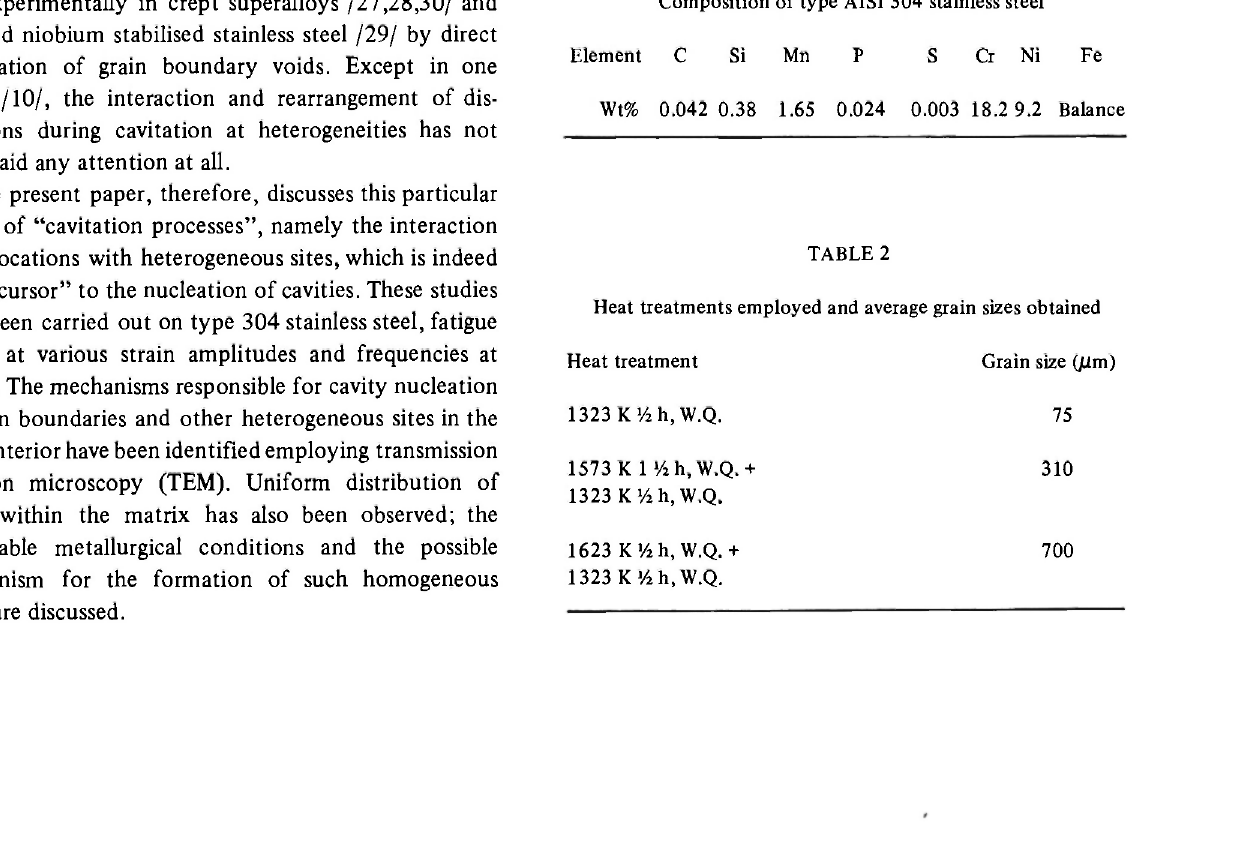
Composition of type AISI 304 stainless steel Element